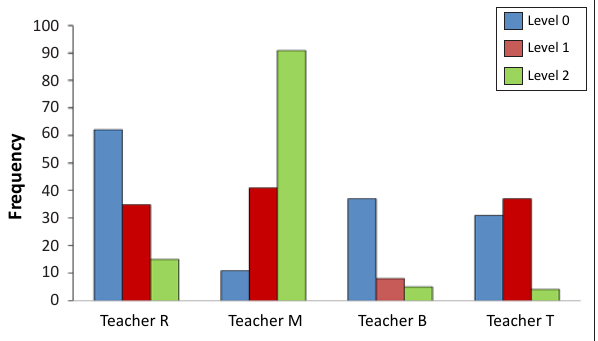
FIGURE 3: Comparison of the levels of quality of the representations of each teacher.